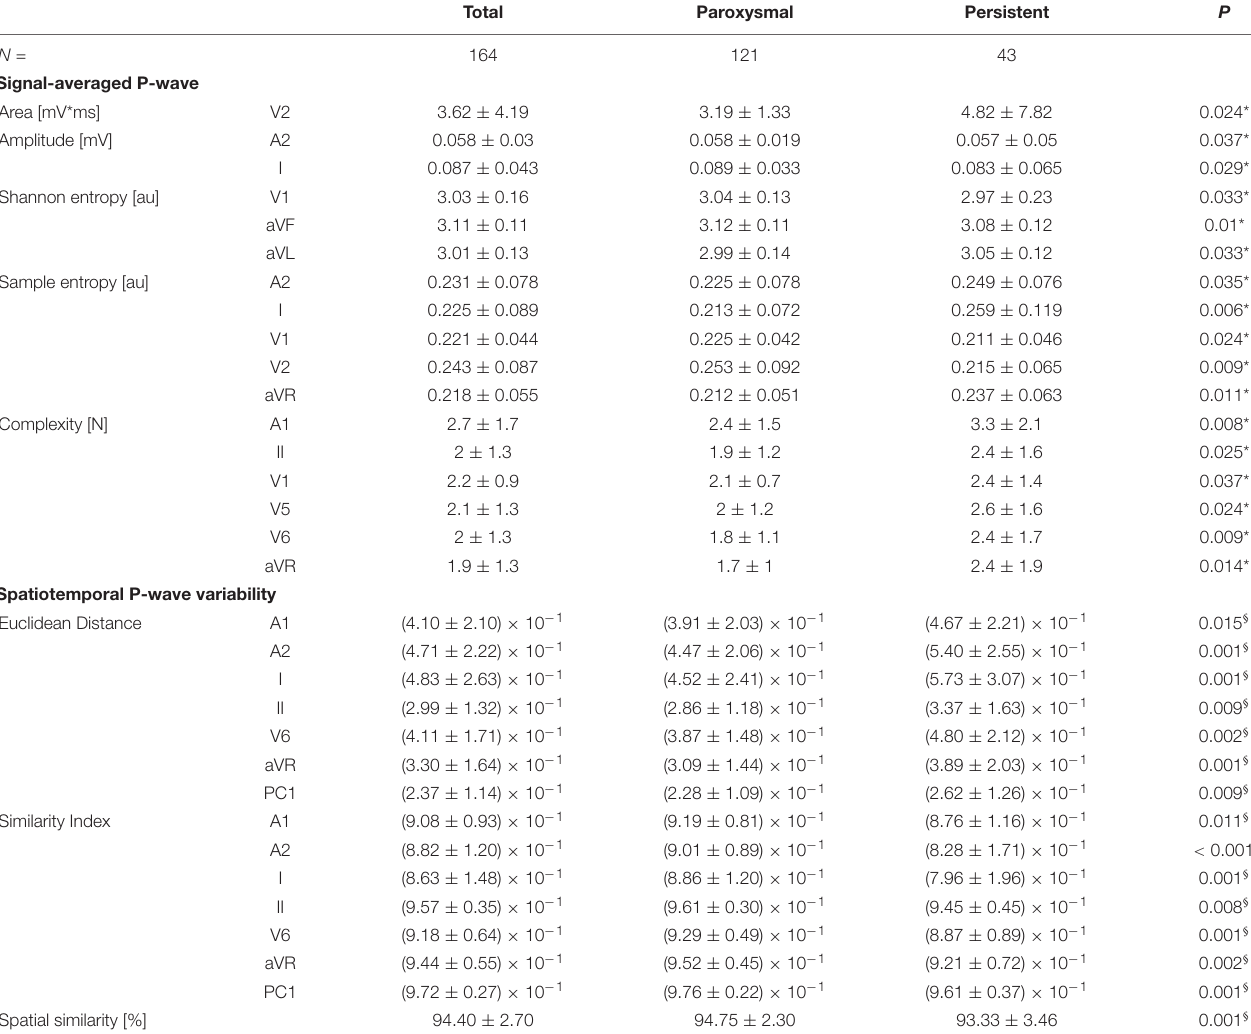
TABLE 2 | P-wave parameters with differences for comparison between patients with paroxysmal and persistent AF. Total Paroxysmal